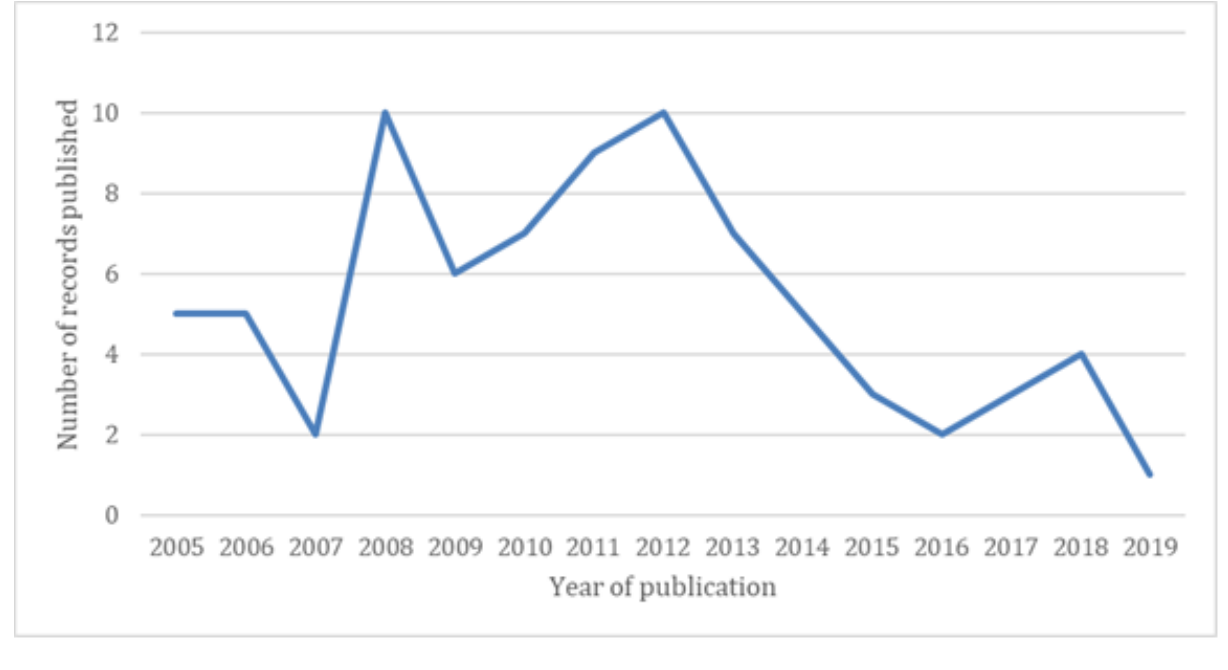
Figure 2. Number of publications per year of publication.